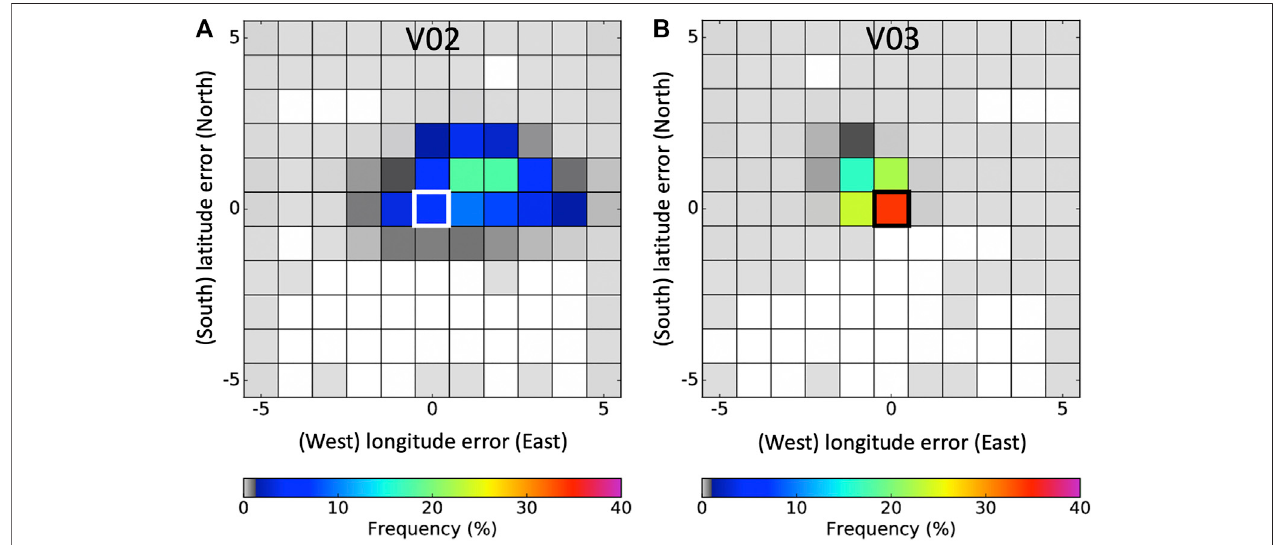
FIGURE 6 | The E-7/V NPP -I1 (0.65 µm) (A) V02 and (B) V03 navigation error frequency plots in 0.25 ° latitude and longitude grid increments. The center white or black box represents no spatial shift or perfect navigation. Note the improved V03 navigation accuracy and precision based on 26,351 E-7/V NPP -I1 total image shifts.